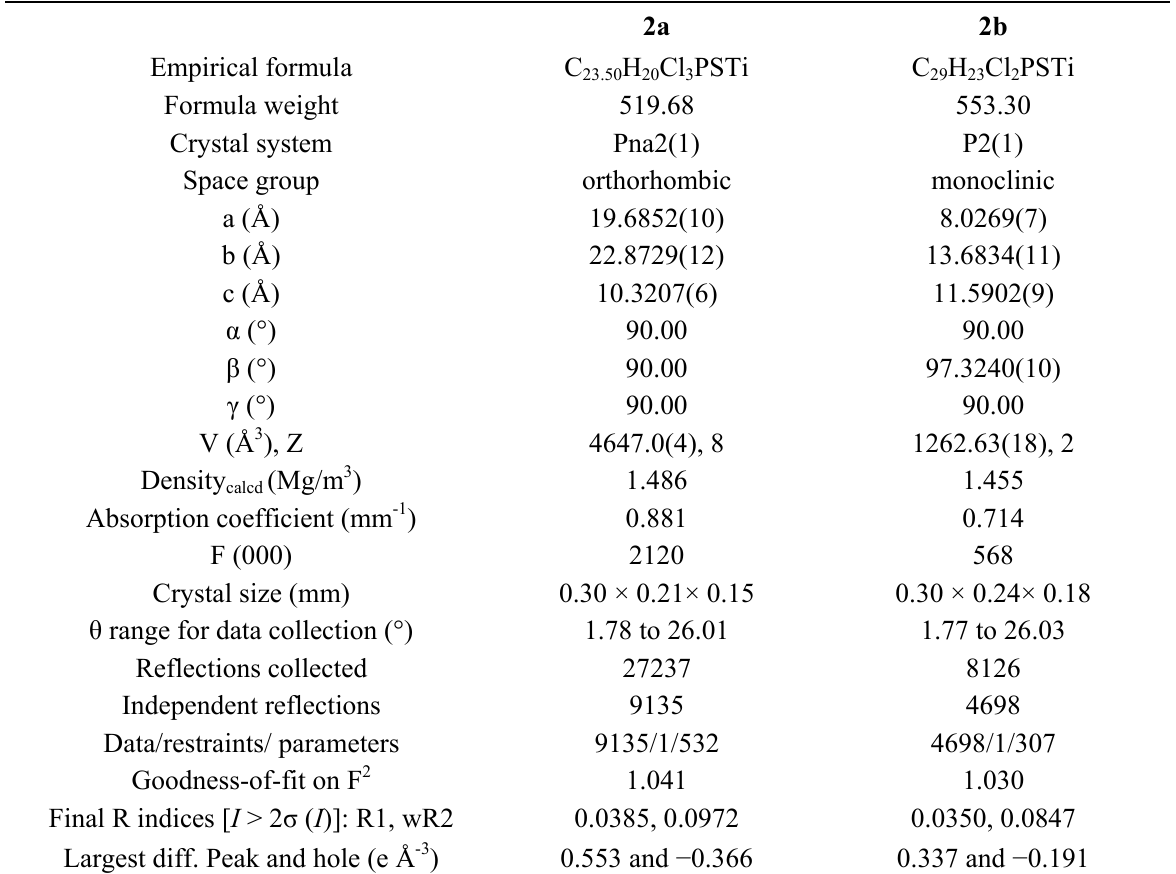
Table 1. Crystal data and structure refinements of complexes 2a–b